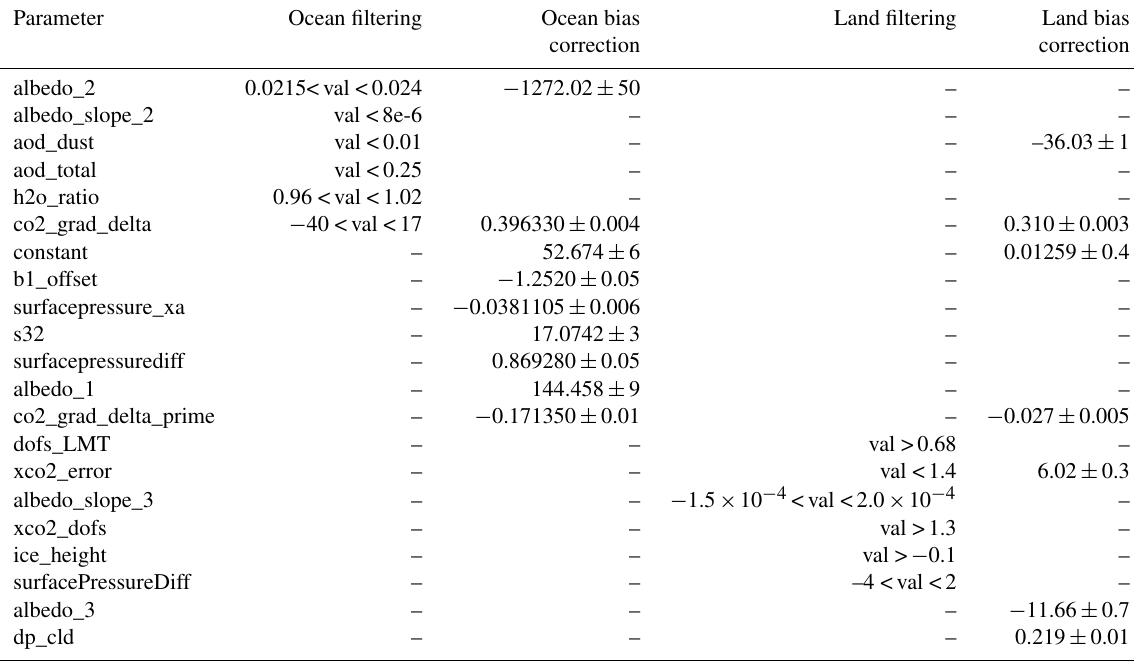
Table A1. Filtering and bias corrections. Note that observations over land and ocean are corrected separately.